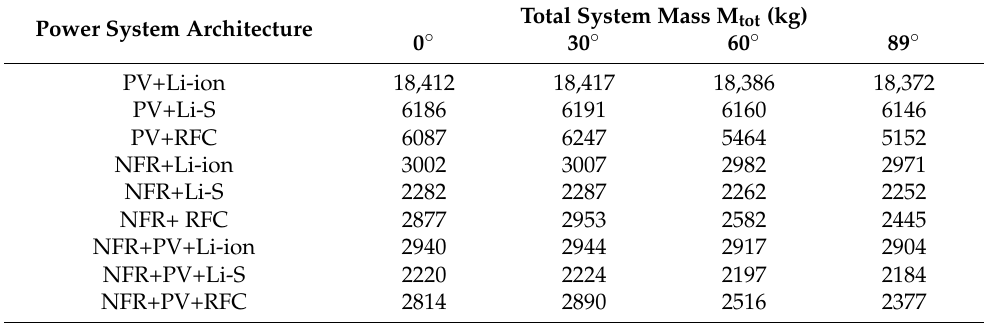
Table 11. Total mass of a power system as a function of its architecture and selenographic latitude.